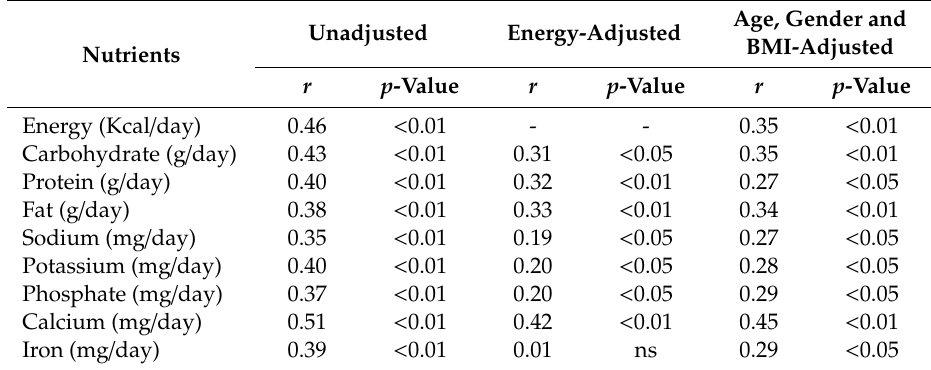
Table 3. Correlations between hemodialysis-food frequency questionnaire (HD-FFQ) and 3-day diet recall (3DDR) methods as per